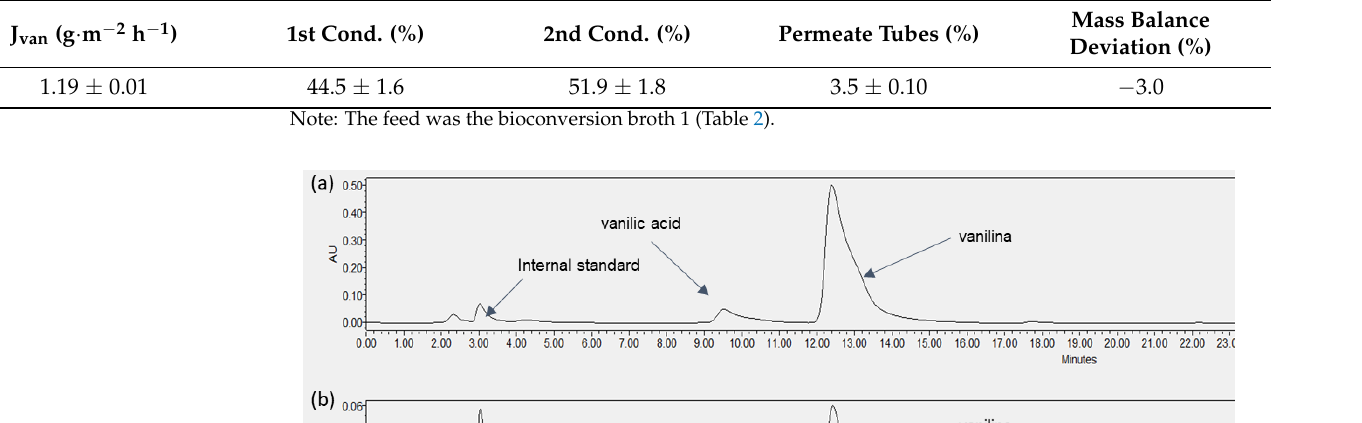
Table 9. Pervaporation-fractionated condensation experiment at 75 ◦ C: total vanillin flux, percentage of permeated vanillin recovered in each section of the permeate circuit, in relation to the total mass of vanillin permeated and mass balance deviation to vanillin.